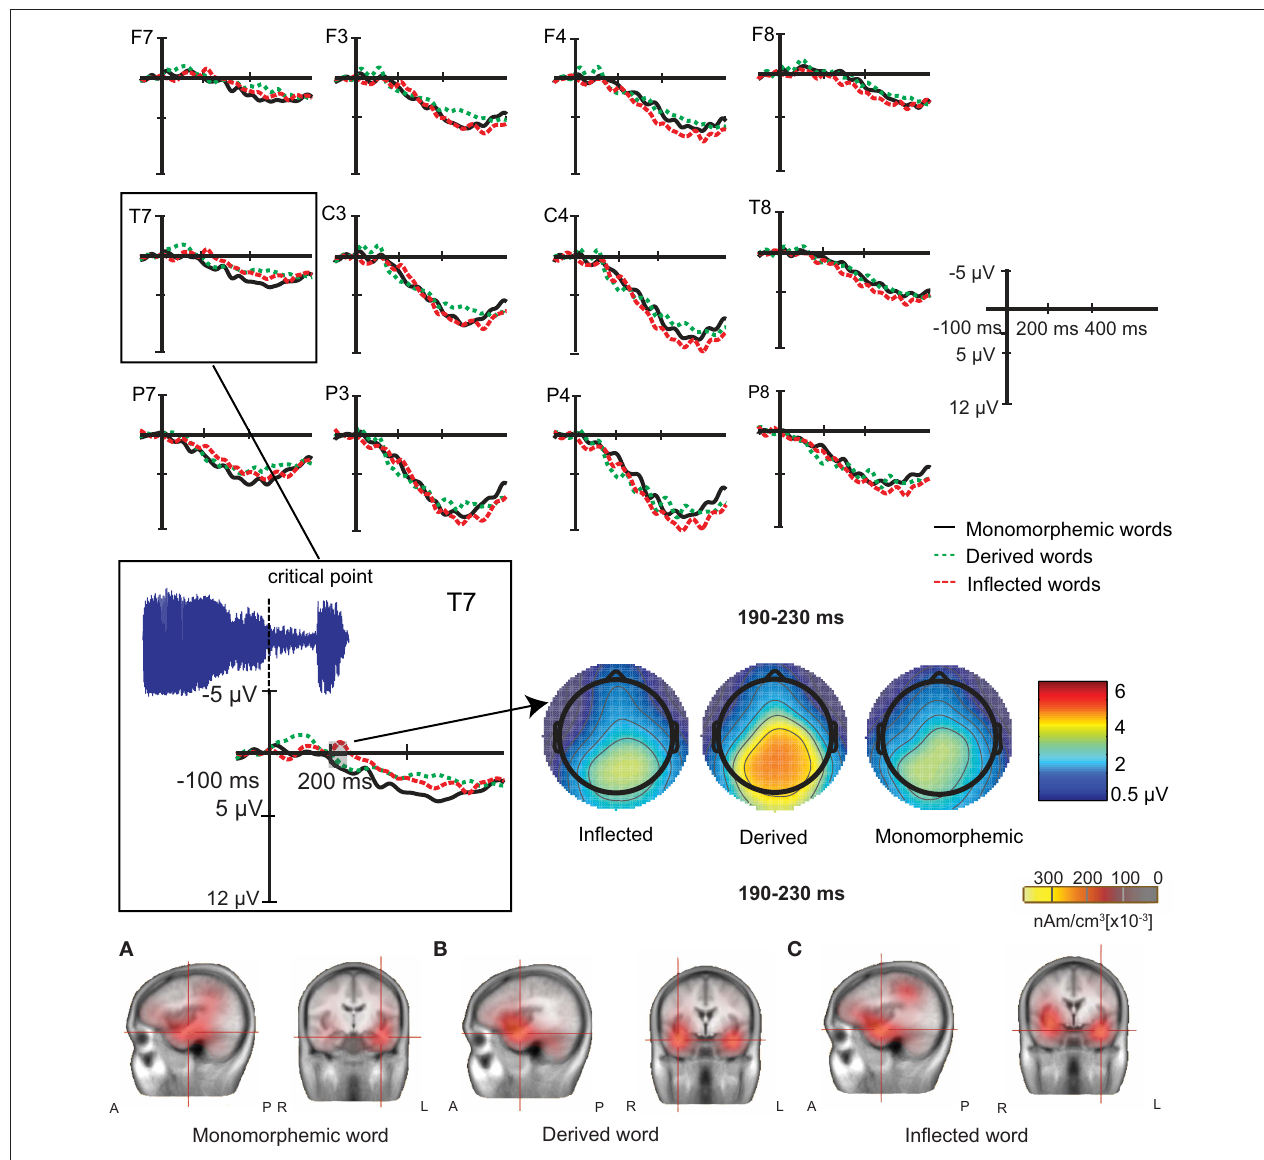
voltage (microvolts, μV). (Middle; left) grand average ERPs from electrode T7. The time-window corresponding to that presented in the topographic maps is shadowed. (Middle; right) topographic maps of the distribution of the negativity in the 190–230 ms time-window after the critical point for the monomorphemic, derived, and inflected words. (Below) LORETA images for grand average ERP responses in the 190–230 ms time-window after the critical point for (A) monomorphemic, (B) derived, and (C)